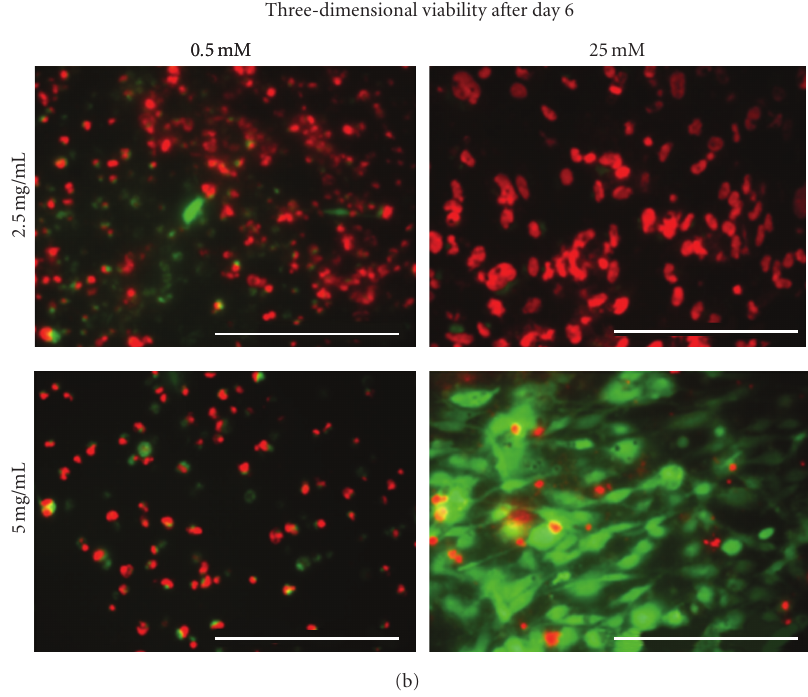
Figure 4: Fluorescence microscopy images indicating the viability of BMSCs in three-dimensional culture after the second and sixth days (increasing glucose concentrations from left to right; increasing collagen densities from top to bottom). Calcein-AM indicates living cells by emitting green light, while ethidium bromide indicates dead cells by emitting red light. After day 2, the 0.5mM environment resulted in low viability, while the 25.0mM environment resulted in high viability. By day 6, the 0.5mM environment and the 25.0mM − 2.5mg/mL group resulted in low viability, while the 25.0mM − 5.0mg/mL group resulted in high viability and confluency. (40x objective; scale bar represents 100 μ